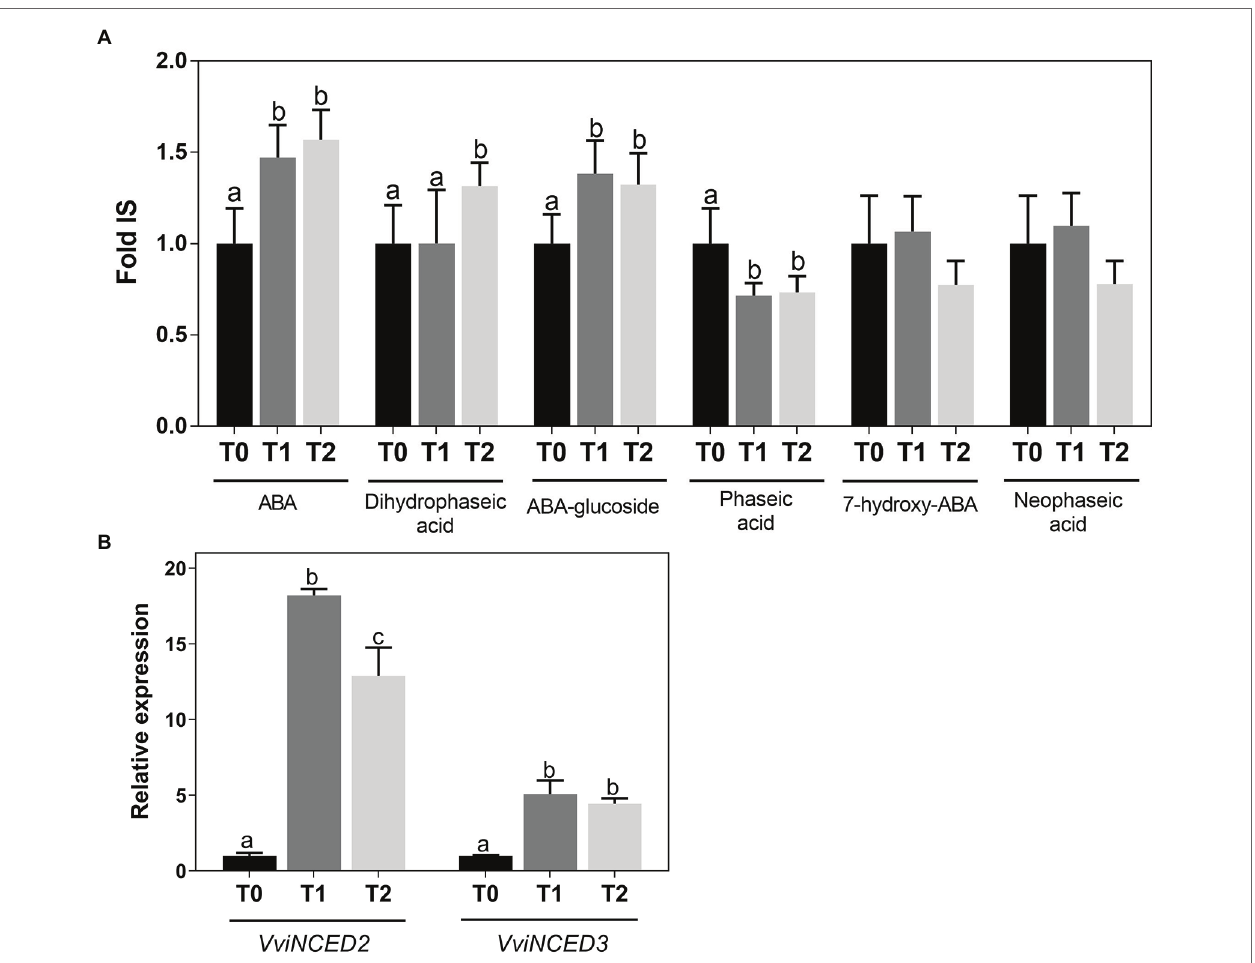
FIGURE 3 | Quantification of ABA and ABA-related metabolites by LC-HRMS (A) and expression of VviNCED genes (B) in Vitis vinifera cv. Vinhão canes incubated at 4 ° C up to 14 days. Results indicate the mean ± SD of three biological replicates per condition. Different letters stand for significant differences ( p ≤